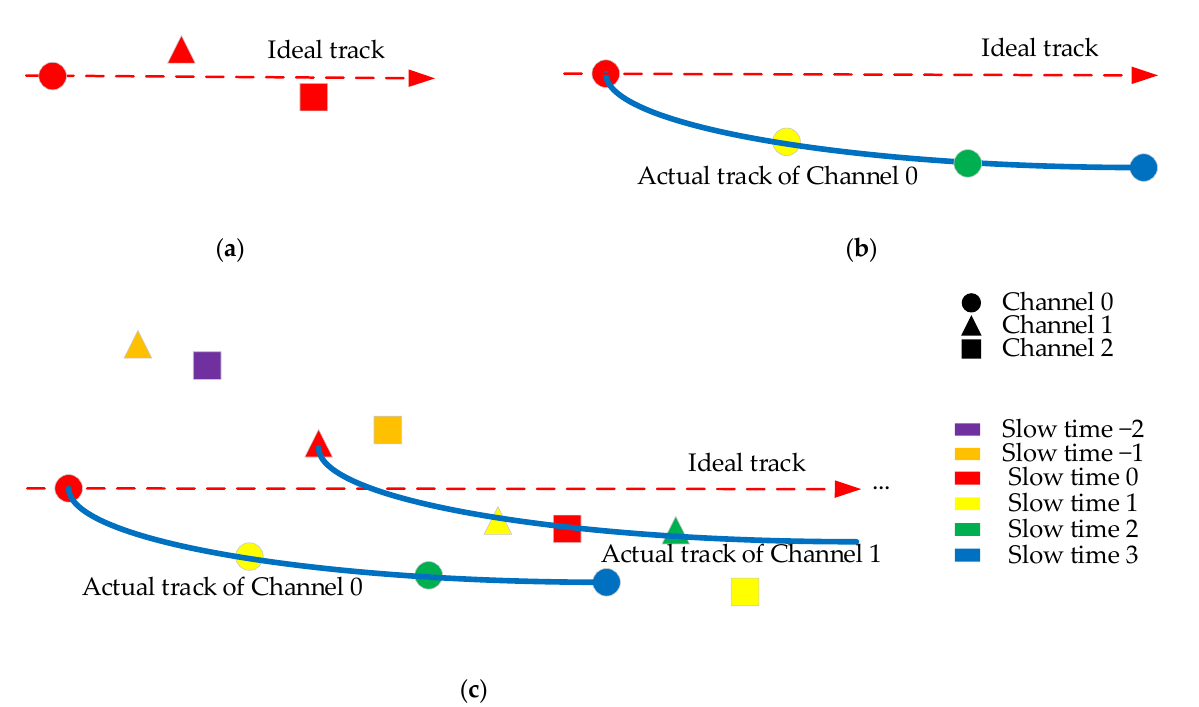
Figure 3. Schematic diagrams of the coupling of the CTB measurement error and the motion error: ( a ) measurement error of the CTB, ( b ) motion error of the single channel, and ( c ) actual spatial arrangement of sampling points.